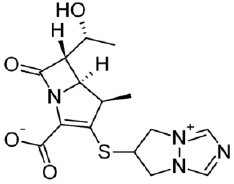
Figure 1. Chemical structure of biapenem (BIPM).